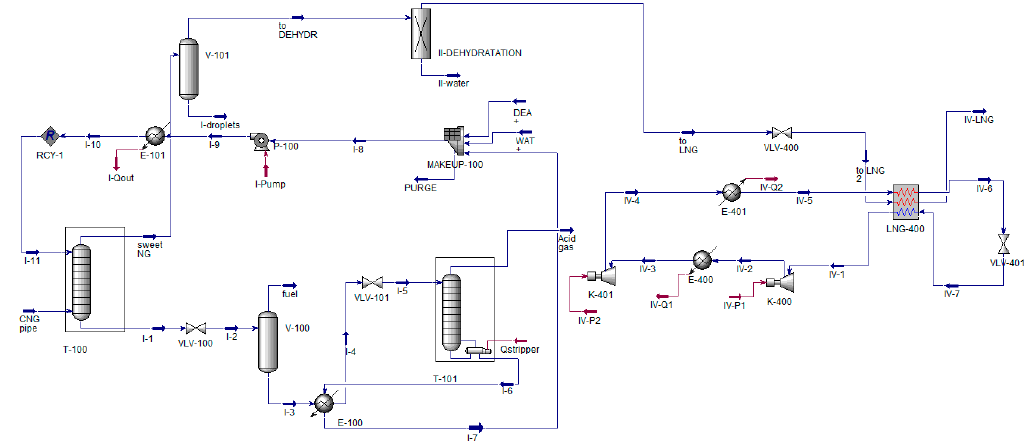
Figure 4. Flowsheet diagram of the simulated LNG plant.